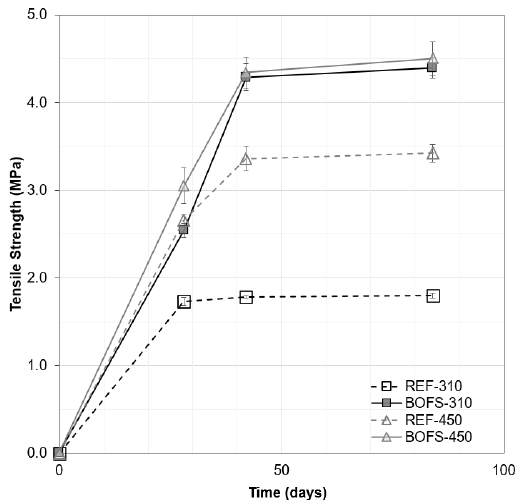
Figure 7. Tensile strength of the produced